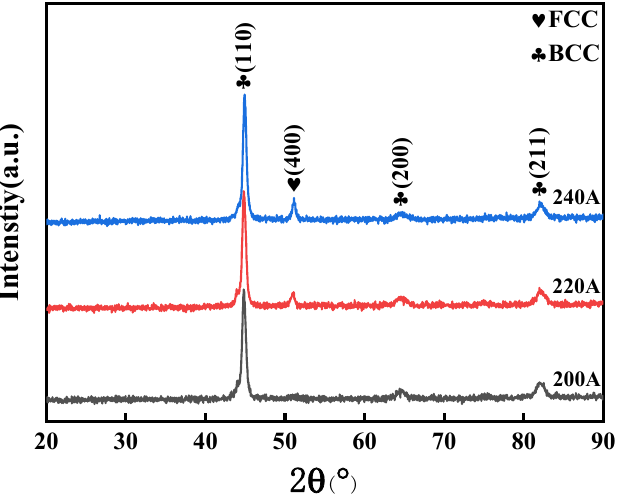
Figure 4. XRD patterns of the FeCrMnCuNiSi 1 high-entropy alloy coatings with different currents.